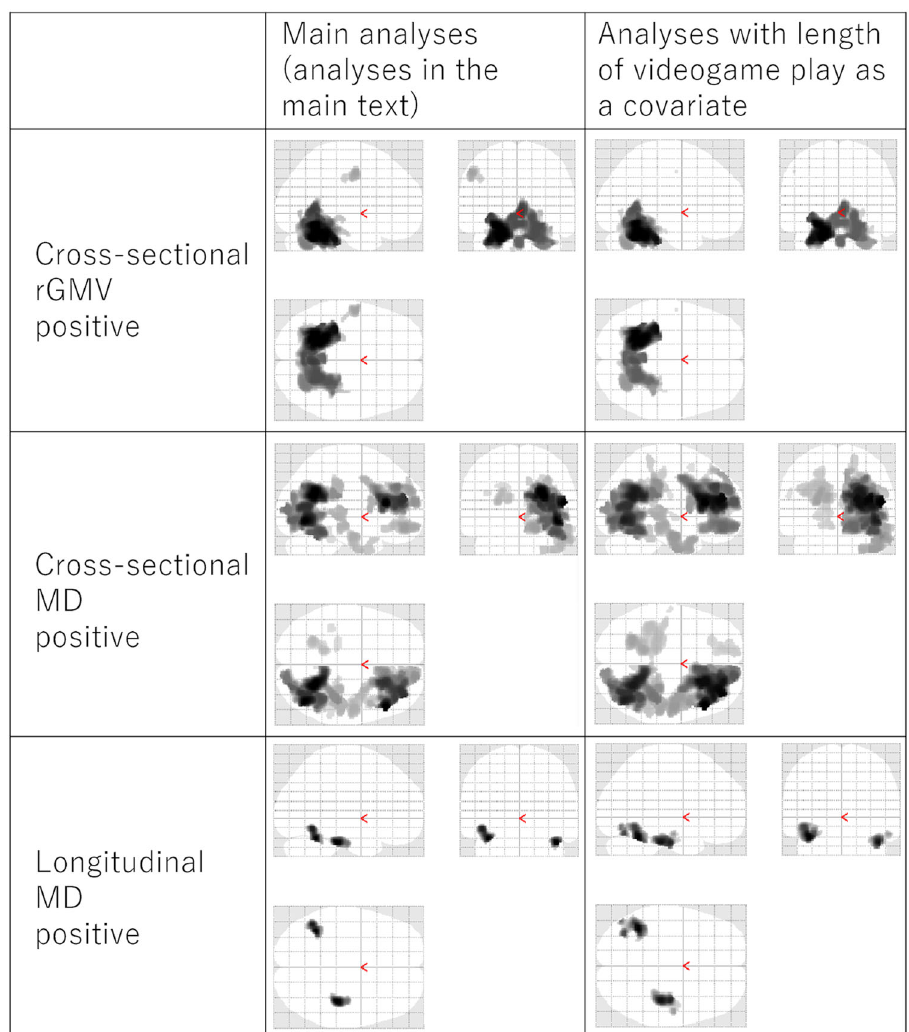
Fig. 8 Comparisons of the results of imaging analyses in the main analyses and those that included length of videogame play as an additional covariate. The fi gures in the left and right columns represent the results of imaging analyses in the main analyses and those that included the length of videogame play as an additional covariate, respectively. The fi gures in the upper, middle, and lower rows represent positive childhood SES associations with rGMV in cross-sectional analyses (upper, left: N = 285, right: N = 278), MD changes in cross-sectional analyses (middle: N = 253, right: N = 247), and MD changes in longitudinal analyses (lower middle: N = 200, right: N = 194). The results shown were obtained using a TFCE of p < 0.05 based on 5,000 permutations in cross-sectional analyses (upper and middle rows). Results are shown using a threshold of p < 0.05 corrected for multiple comparisons in cluster size tests, with a voxel-level cluster-determining threshold of p < 0.05 (corrected for FDR) in longitudinal analyses (lower row). Associated regions are superimposed on a glass brain image from SPM. Similar associations were obtained by two types of